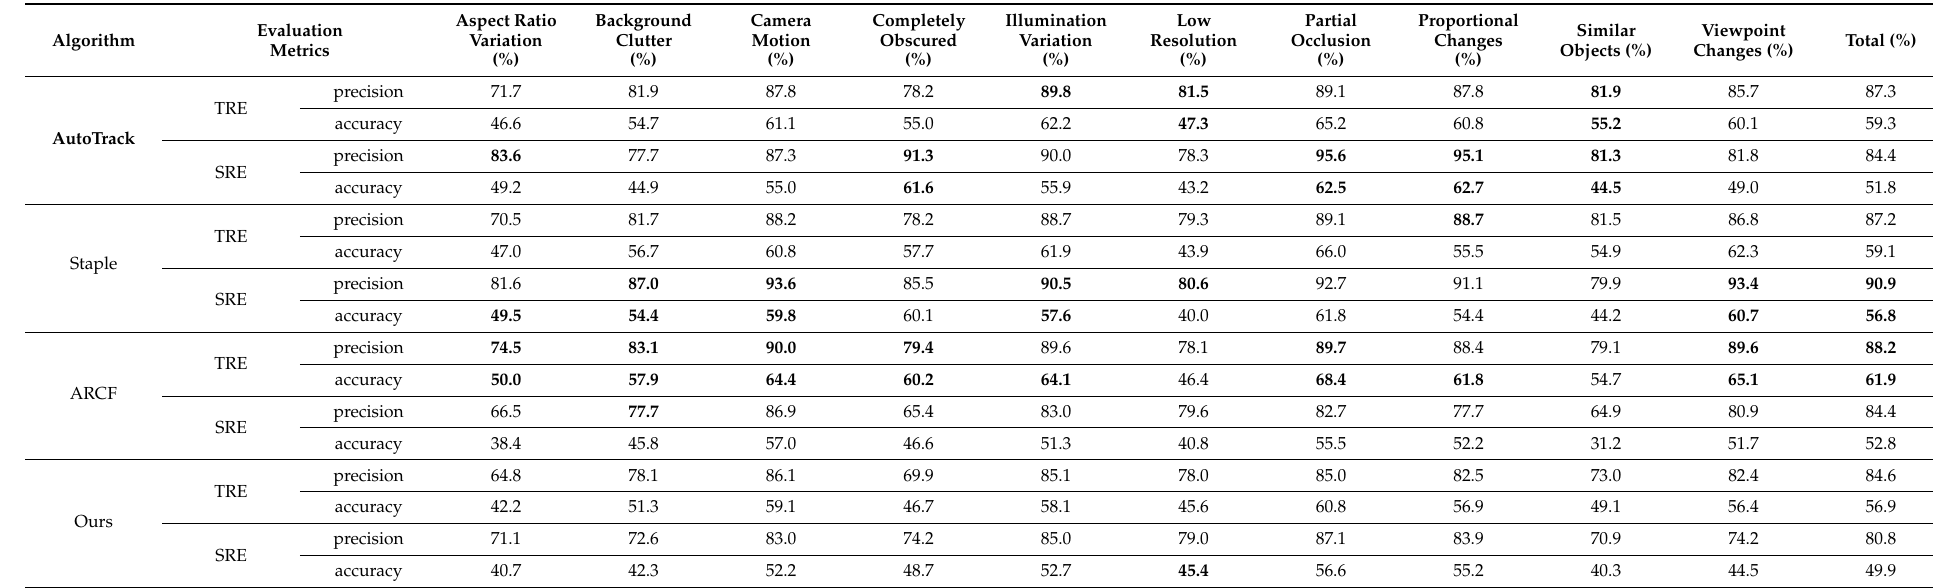
Table 5. Comparison of the precision and accuracy of different correlation filtering algorithms under different